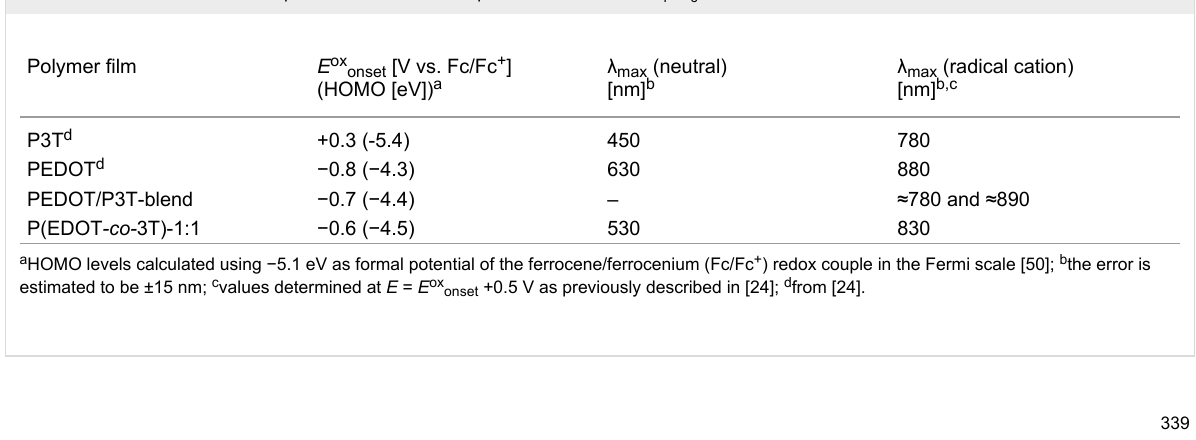
Table 1: Summary of absorption and electrochemical characteristics of polymer films electrochemically deposited on ITO electrodes under potentio- static control derived from in situ spectroelectrochemical experiments in 0.1 M NBu 4 PF 6 /MeCN.